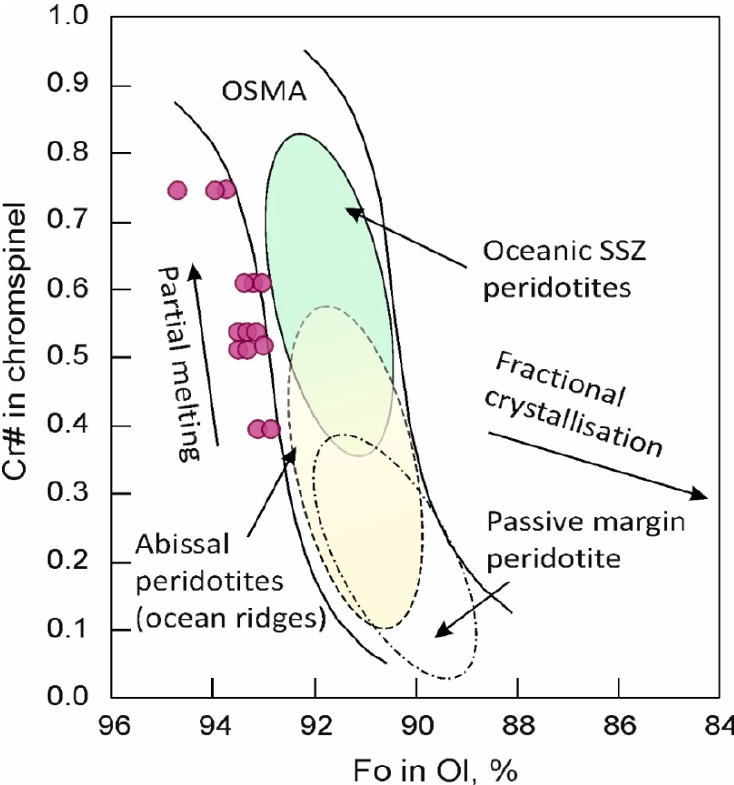
Figure 12. Compositional relationships between Fo content in olivine and Cr# in chromspinel from Sabantuy chromite paleoplacer. The olivine–spinel mantle array (OSMA) is after Arai [4,48]. SSZ—supra-subduction zone peridotites.